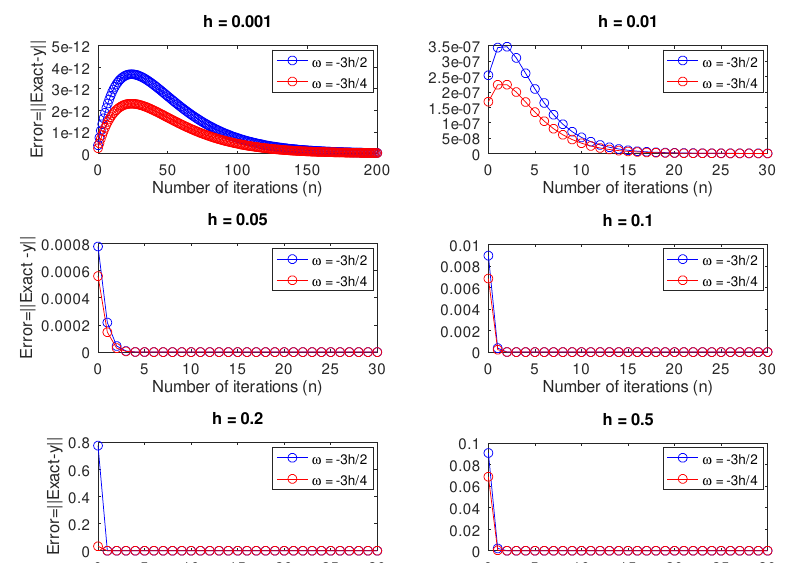
Figure 7. Comparison of the norm of the difference between the exact solution and the vector [ y n + 1 , y ] T for different values of h using the discrete schemes (3)–(6) corresponding to ω = n + 3 2 and the discrete schemes (7)–(10) corresponding to ω =